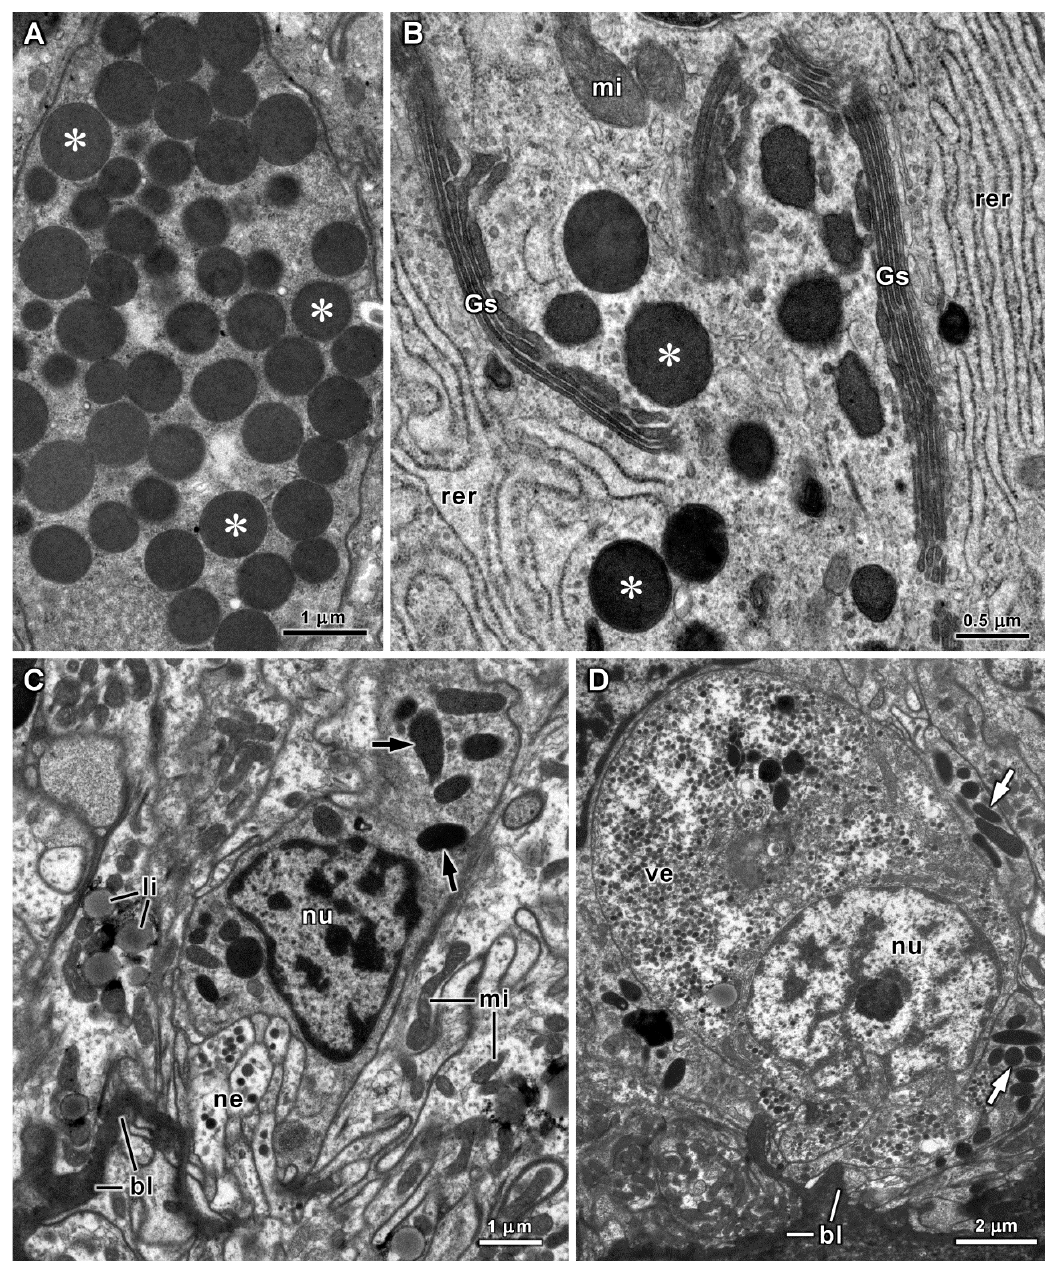
Figure 9. Ultrastructure of the stomach in A. fascicularis ( A ) and C. angulata ( B – D ). ( A ) Electron-dense vesicles (asterisks) in the apical region of a basophilic secretory cell. ( B ) Golgi stacks (Gs) and rough endoplasmic reticulum cisternae (rer) in a basophilic secretory cell containing electron-dense vesicles (asterisks). ( C ) Basal cell with electron-dense vesicles (arrows) in connection with a nerve terminal (ne). ( D ) Intraepithelial neuron with a large number of small vesicles (ve) in the cytoplasm. Basal cells with the electron-dense secretory vesicles (arrows) are visible around the neuron. bl—basal lamina, li—lipid droplets, mi—mitochondria, nu—nuclei.